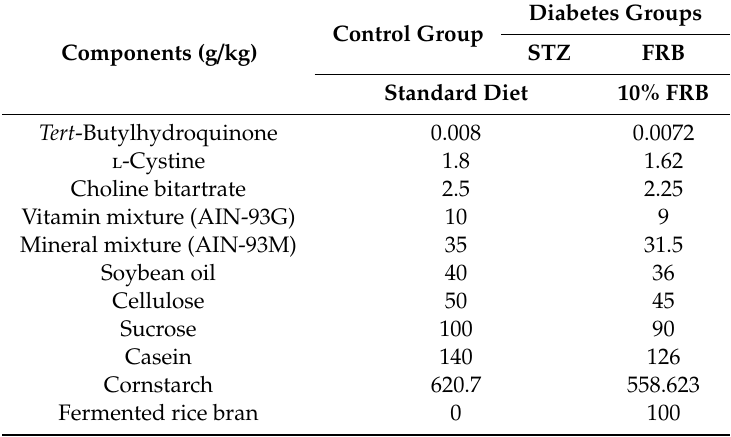
Table 1. Details of the diet formula used in the present